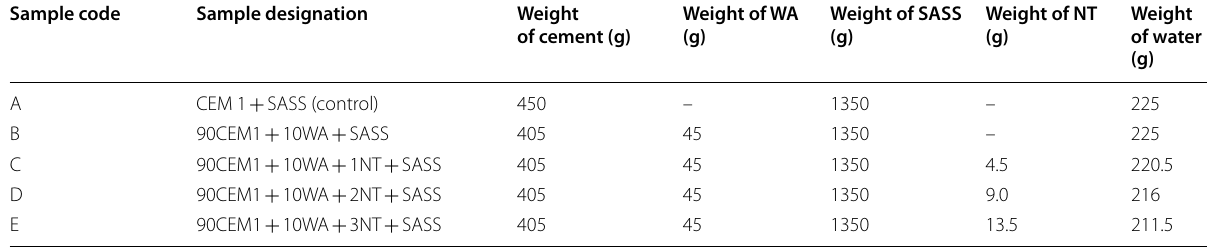
Table 4 Mix proportion of mortar